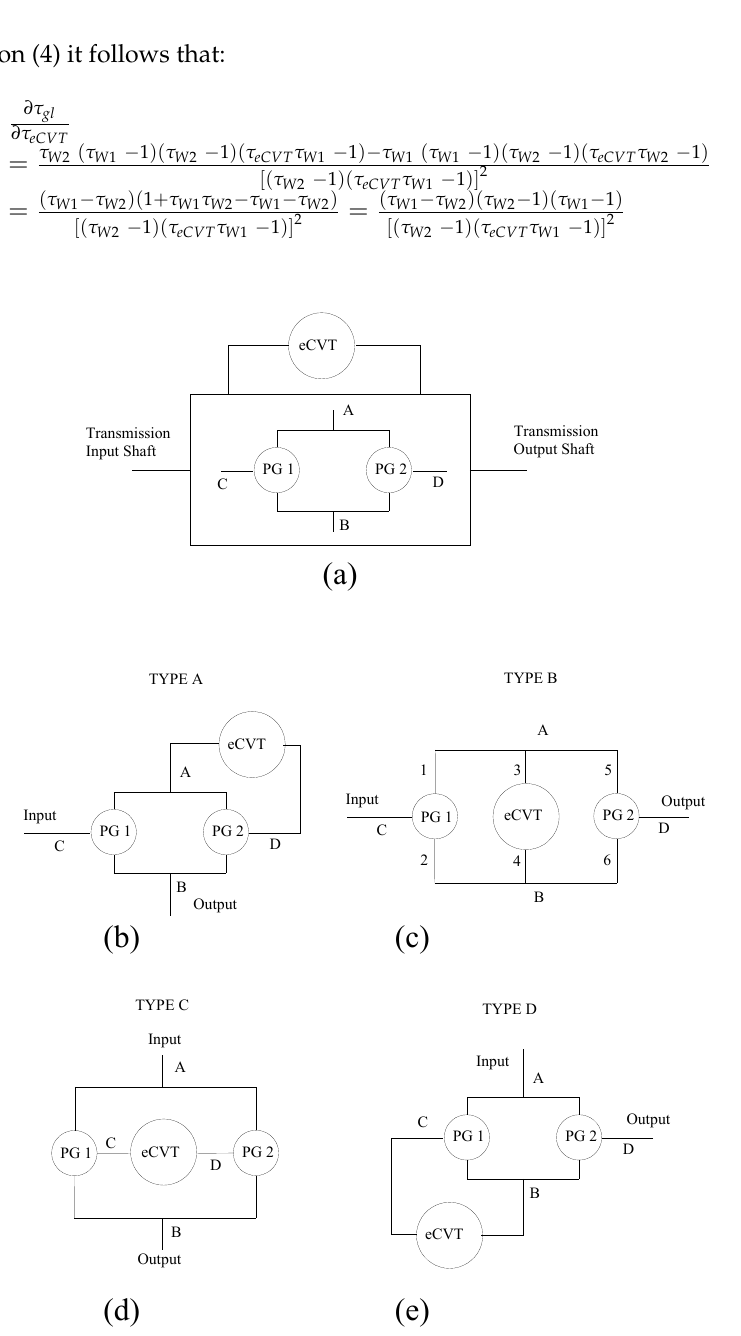
Figure 1. ( a ) Compound ECVT based on the four-port mechanical power-split device; ( b ) type A arrangement; ( c ) type B arrangement; ( d ) type C arrangement; ( e ) type D arrangement; eCVT: electric continuously variable transmission PG1: first planetary gear; PG2: second planetary gear.